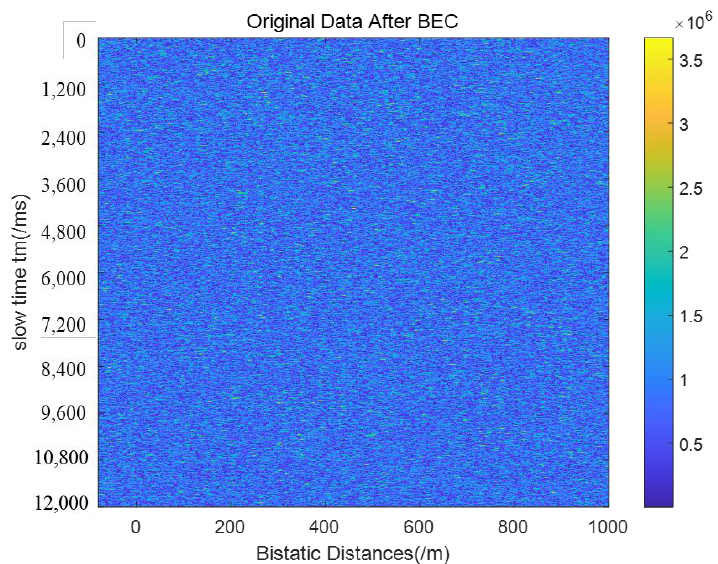
Figure 15. Original data after BEC processing.